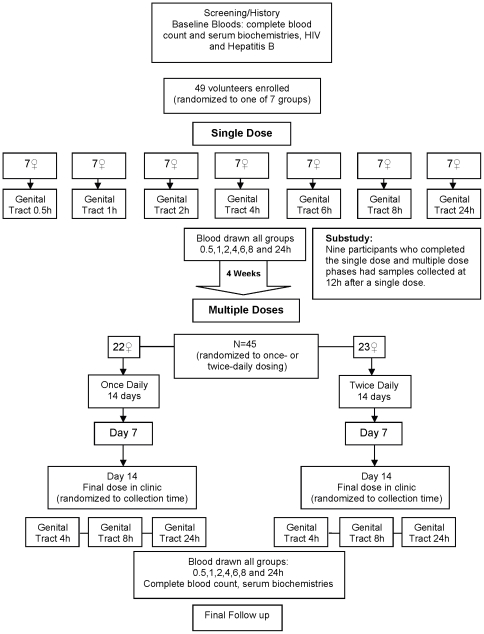
Study procedures.